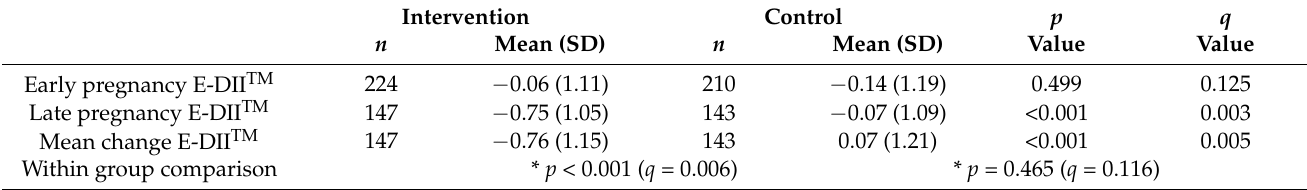
Table 2. E-DII TM throughout gestation and impact of PEARs lifestyle